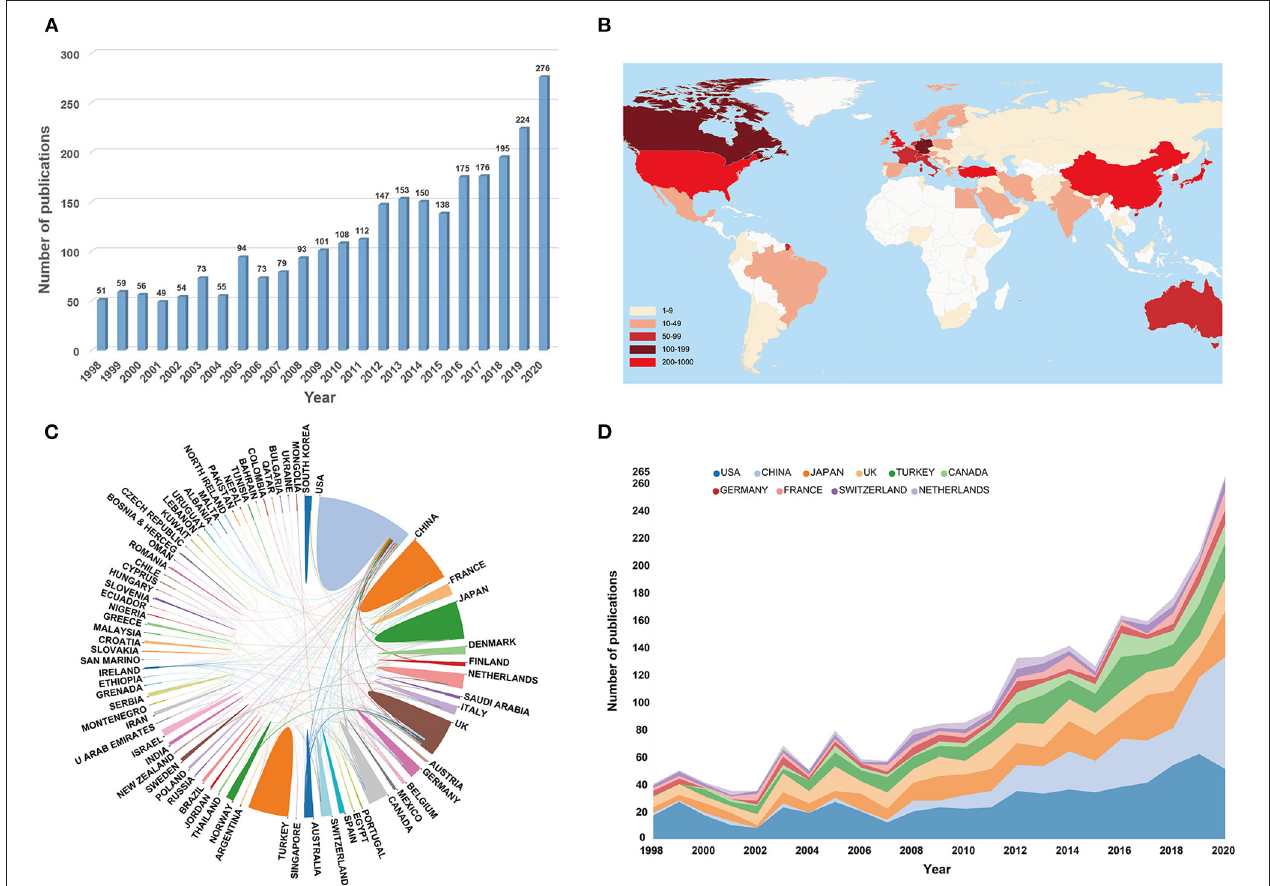
FIGURE 3 | (A) The number of annual publications on DDH from 1998 to 2020. (B) A world map displaying the global scientific output of DDH research. These different colors in the map represent different density values. (C) The cooperation map of countries/regions involved in DDH research. The color area indicates the number of publications. The larger the area, the more the counts. The lines represent the collaborative relationship between countries, and the thicker line indicates a closer relationship. This map was generated from an online analysis platform (https://bibliometric.com). (D) The publication trends of the top 10 active countries in DDH research from 1998 to 2020. The width of the line in different colors could reflect the changing trend of annual publications in different countries at different time points.